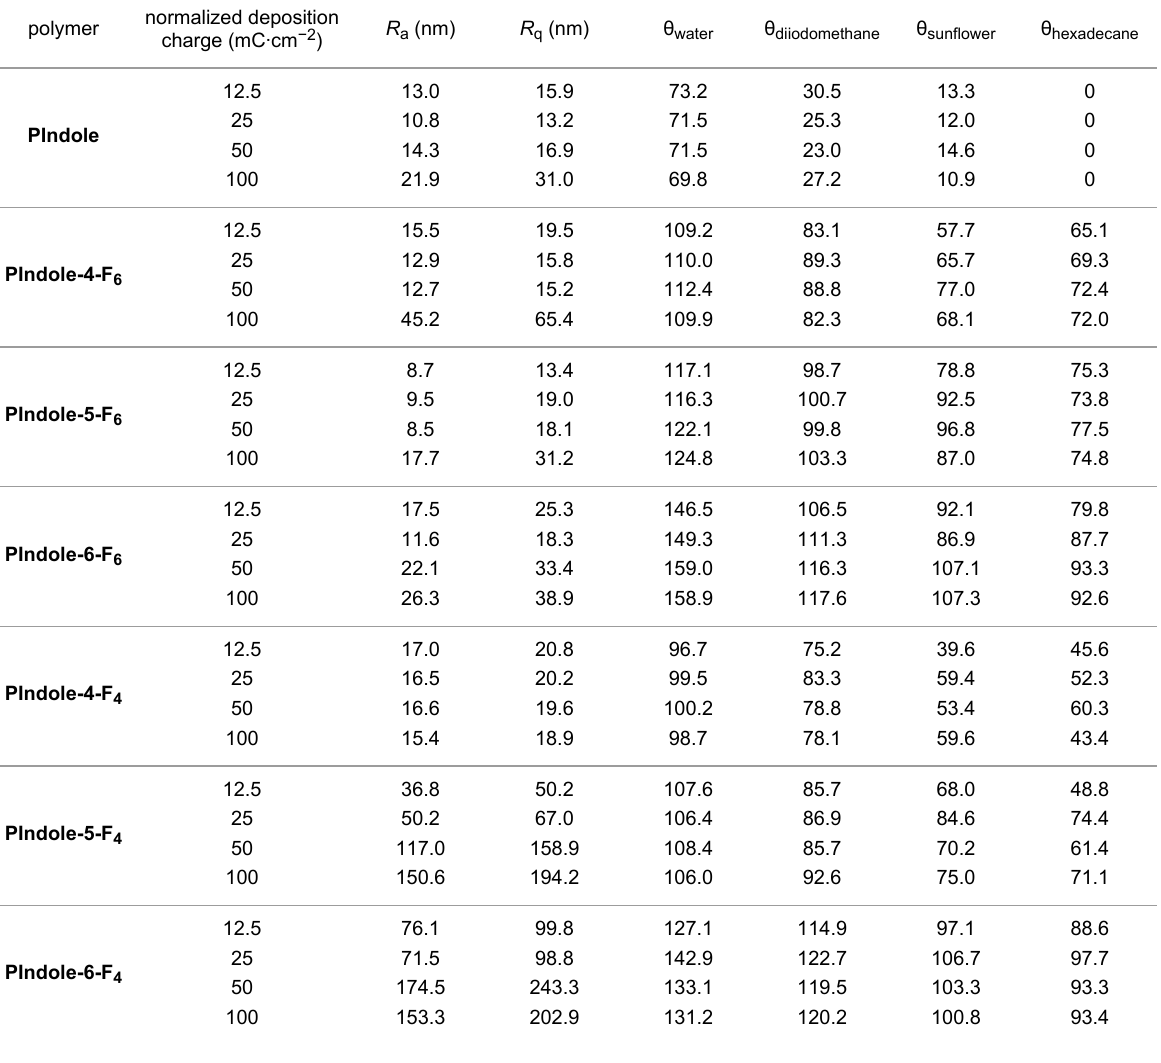
Table 2: Arithmetic roughness ( R a ), quadratic roughness ( R q ) and apparent contact angles ( θ ) for the four probe liquids (water, diiodomethane, sunflower oil and hexadecane) for the polymers as a function of the normalized deposition charge.